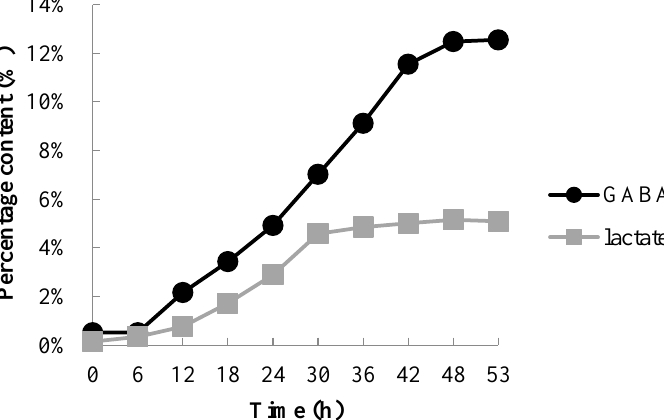
Figure 1. Changes of gamma amino butyric acid and lactate contents during fermentation of hydrolyzed oyster as affected by fermentation time (h).